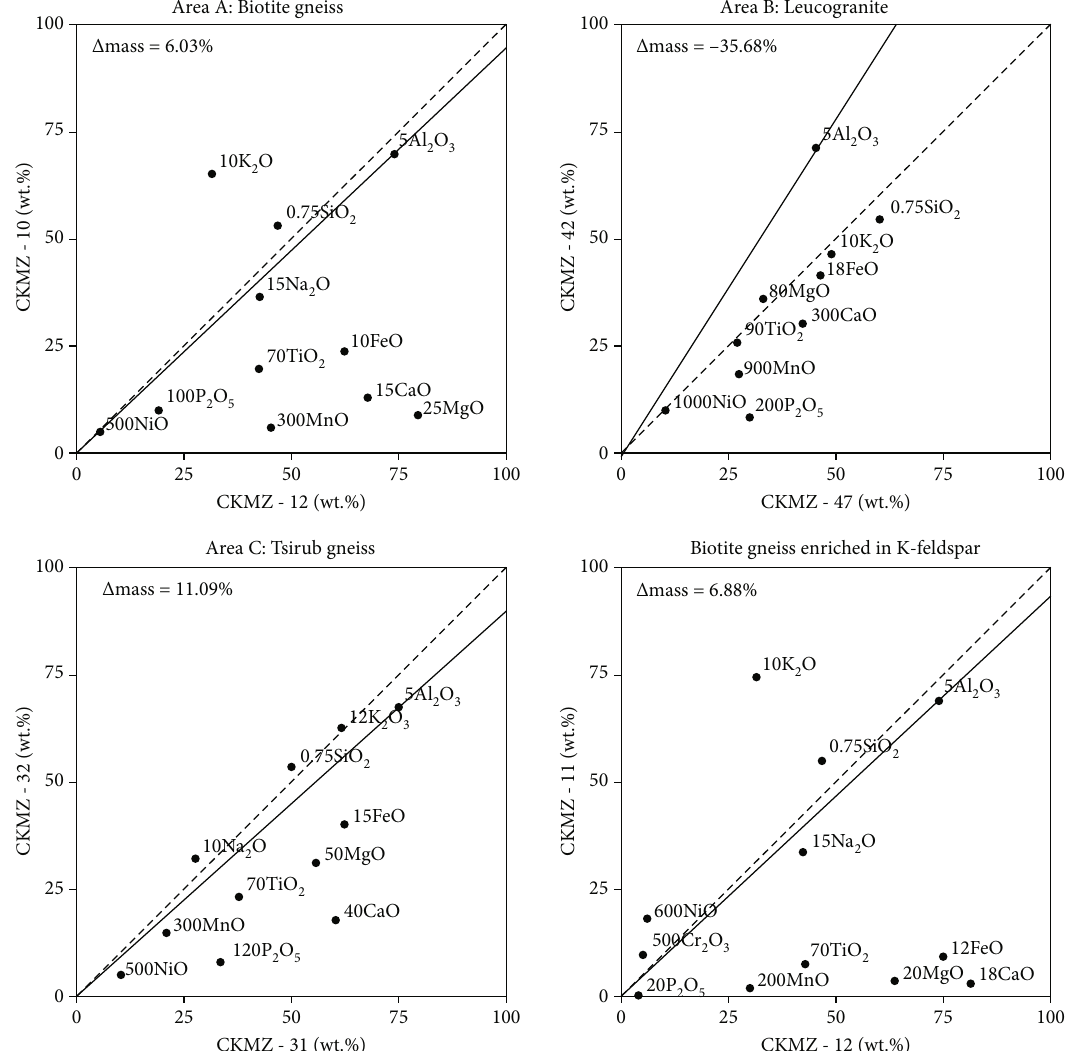
Figure 8: Part of the isocons described in the text showing changes in element concentrations and mass changes between two samples. Rock descriptions can be found in Table S1, and the remaining isocons can be found in Figure